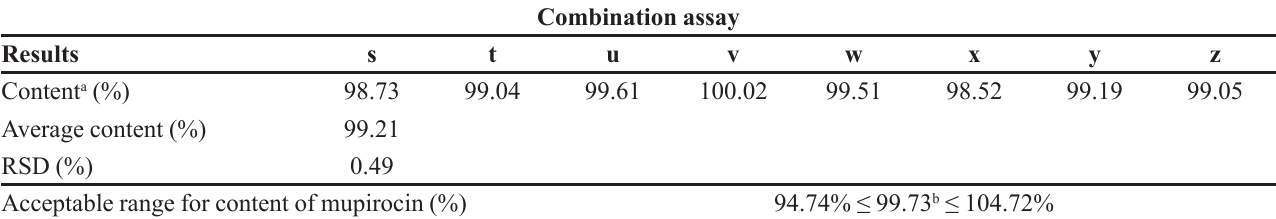
TABLE IV - Combinations tested to evaluate the robustness, evaluating condition